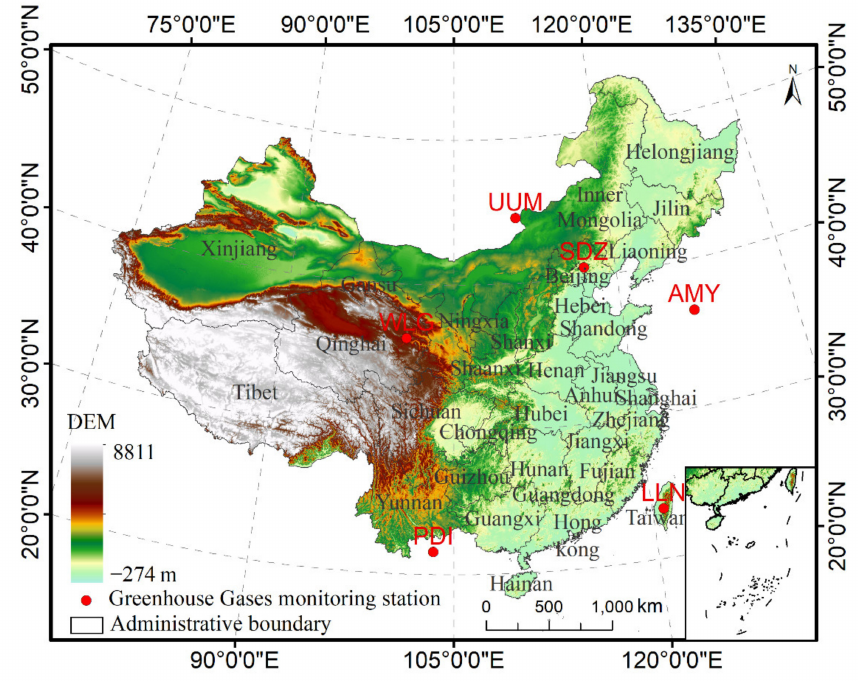
Figure 1. China’s geographic location and methane surface observation stations. Table 1. Observed greenhouse gas information by surface